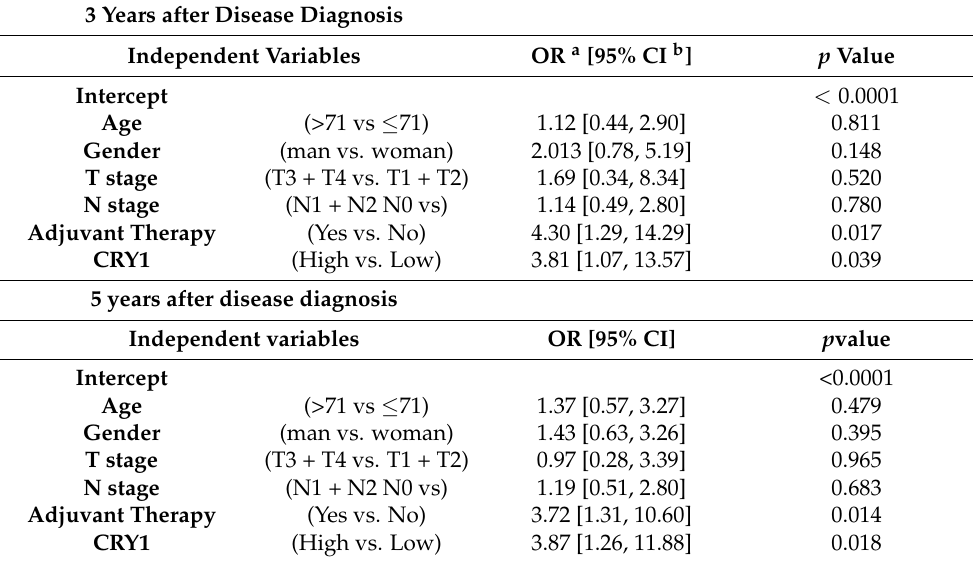
Table 7. Results of logistic regression for metastasis development within 3 and 5 years after dis- ease